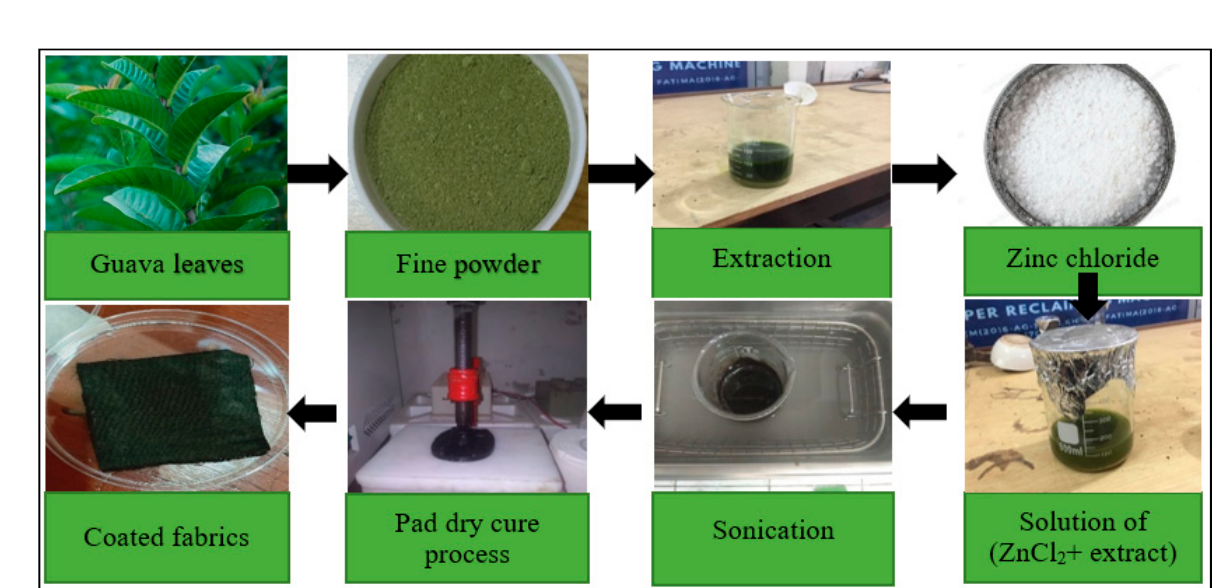
Figure 2. Illustration of steps involved in the one-pot production of ZnO and coating over plasma-activated cotton fabric.